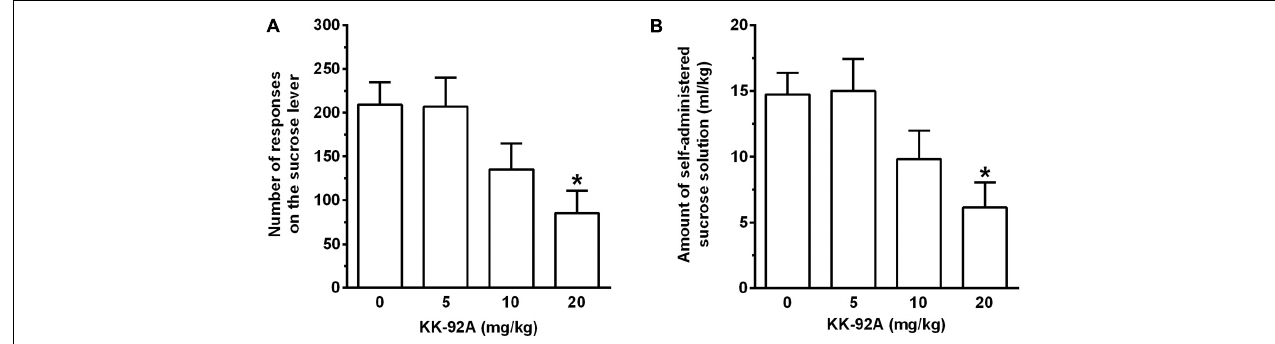
FIGURE 2 | Effect of acute treatment with the positive allosteric modulator of the GABA B receptor, KK-92A, on number of lever-responses for sucrose solution (A) and amount of self-administered sucrose solution (B) in female Sardinian alcohol-preferring rats. Rats were initially trained to lever-respond for sucrose solution (0.7% w/v in water) [Fixed Ratio (FR) 5 (FR5)] and water (FR1) in daily 30-min self-administration sessions. Once lever-responding had stabilized, rats were tested with KK-92A under the same FR schedule of reinforcement. KK-92A was administered intraperitoneally 30 min before the start of the self-administration session. Each bar is the mean ± SEM of n = 11 rats. * P < 0.05 in comparison to the rat group treated with 0 mg/kg KK-92A (Tukey’s test).